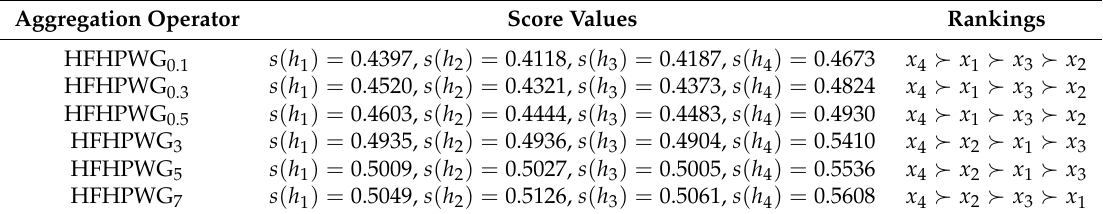
Table 3. Score values obtained with the HFHPWG operator and rankings of alternatives. Aggregation